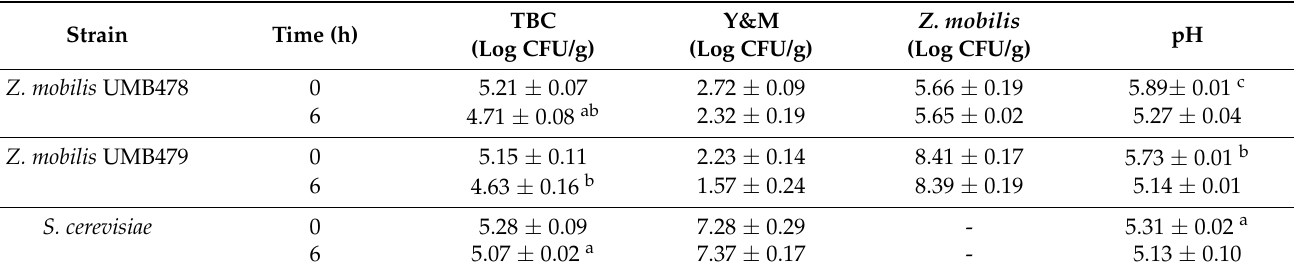
Table 5. Total bacterial count (TBC), yeasts and molds (Y&M) and Z. mobilis population (Log CFU/g) in doughs at time 0 and after 6 h of leavening with Z. mobilis UMB478 and UMB479 and S. cerevisiae . Mean and standard deviation of two replicates; different superscript letters within a column indicate significantly different samples ( p <